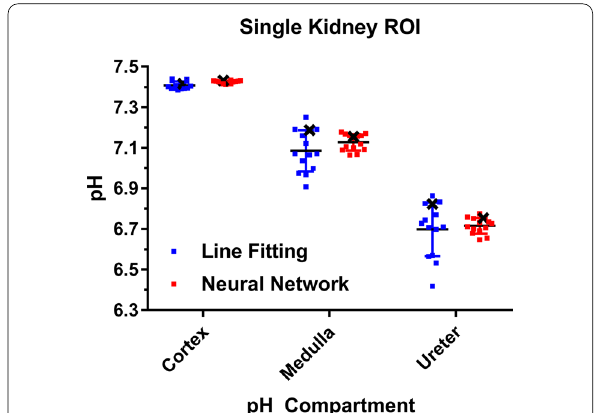
Fig. 8 pH compartments averaged over regions of interests in single kidneys of mice. pH values derived from line fitting show stronger variations between single kidneys and different subjects compared to predictions from CNN mix .pH values for each compartment show good agreement between line fitting and neural network predictions for individual kidneys (example indicated by black